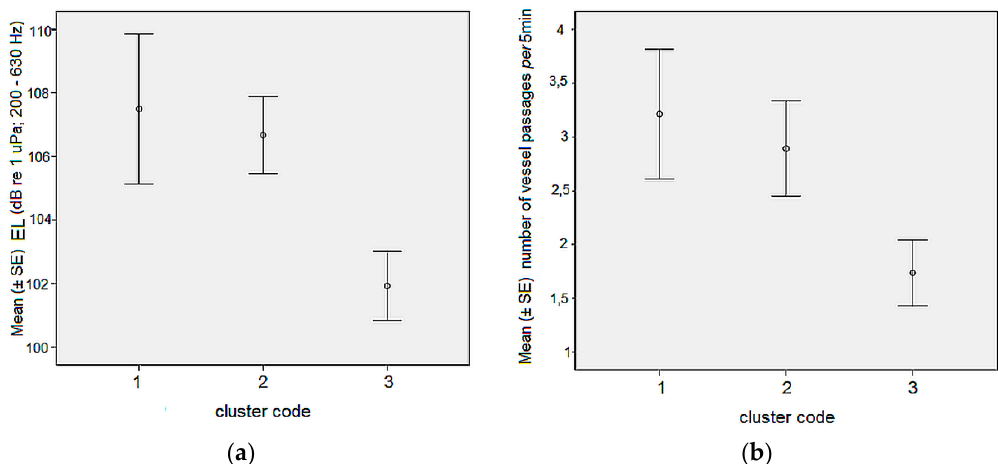
Figure 6. Mean (±standard error) ( a ) noise levels (energy level (EL) 200–630, dB re 1 μ Pa) and ( b ) number of vessel passages at the listening points belonging to the three groups highlighted by cluster analysis for the afternoon recordings.